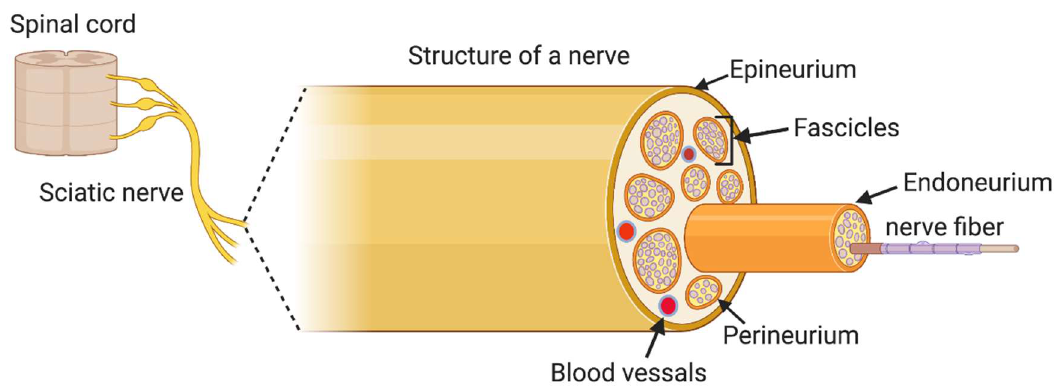
Figure 2. The structure of a peripheral nerve.